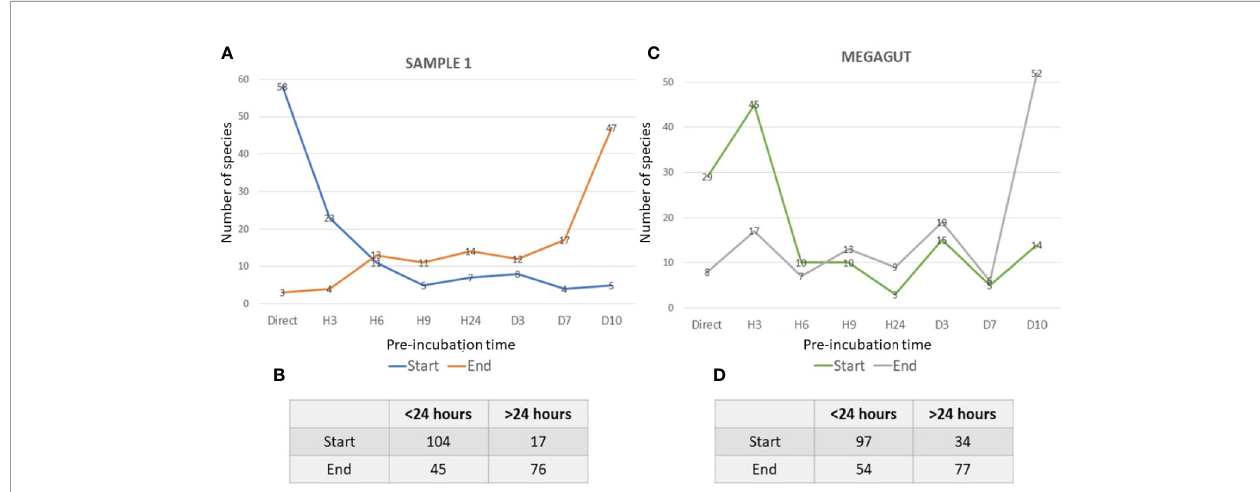
FIGURE 3 | Representative curves of the beginning and the end of the growth of bacterial species identi fi ed in stool samples as a function of the incubation time. (A) The blue curves represent the number of bacterial species that start growing as a function of the different incubation times in the fi rst stool sample. The orange curves show the number of bacterial species ending their growth as a function of the different incubation times in the fi rst stool sample. (B) Table represents the number of bacteria that start or end their growth before or after 24 h in stool sample 1. (C) The green curves represent the number of bacterial species that start growing as a function of the different incubation times in Megagut stool sample. The gray curves show the number of bacterial species ending their growth as a function of the different incubation times in the Megagut stool sample. (D) Table represents the number of bacteria that start or end their growth before or after 24 h in the second stool sample named